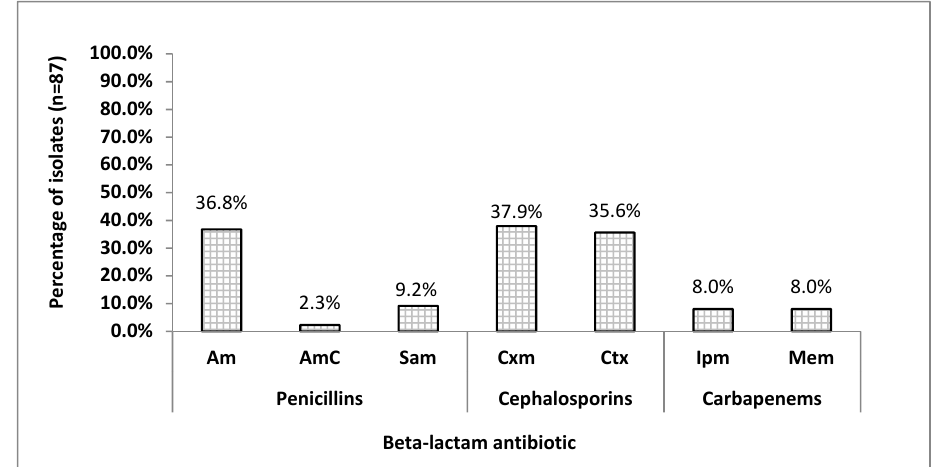
Figure 1. Distribution of resistance to beta-lactam antibiotics among Haemophilus parainfluenzae isolates ( n = 87) . Am—ampicillin, Cxm—cefuroxime (oral), Ctx—cefotaxime, Ipm—imipenem, Mem—meropenem, AmC—amoxicillin–clavulanate,